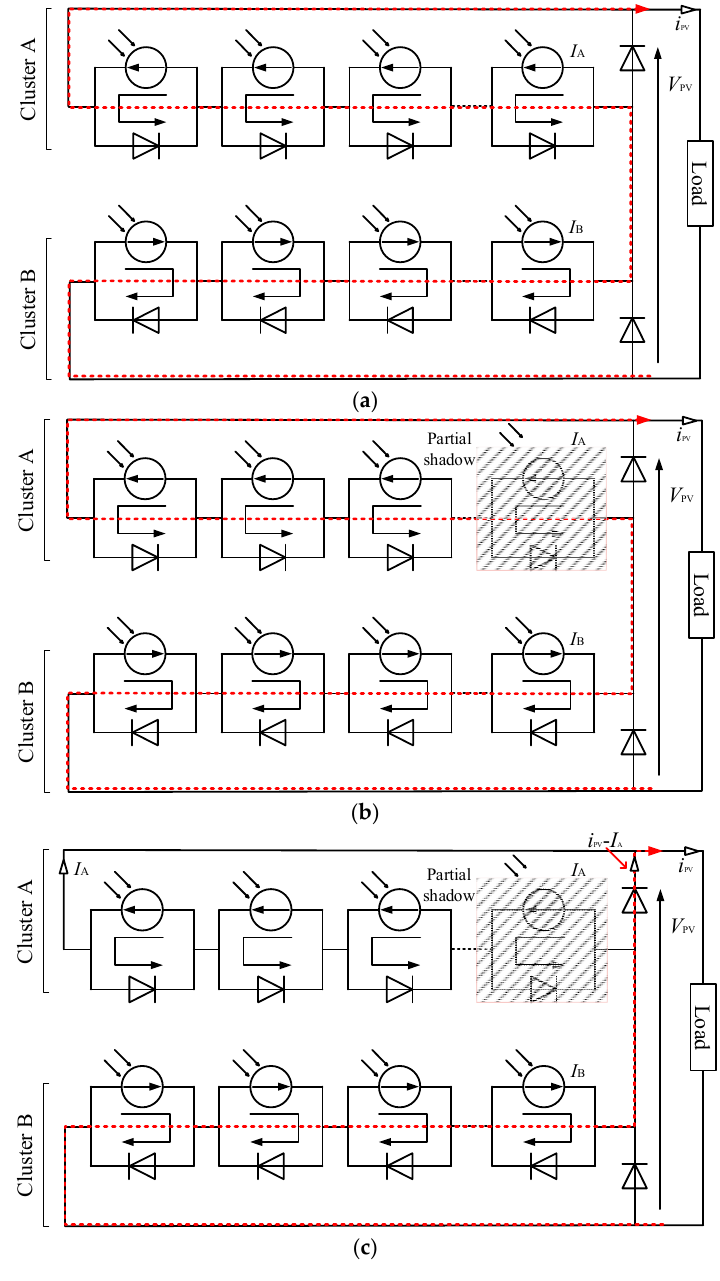
Figure 6. The equivalent circuit of a solar module, red dashed lines are operating current path: ( a ) Unshaded condition, I A = I B ; ( b ) Partial shadow on hot-spot cell I A < I B , I A ≥ i pv ; ( c ) Partial shadow on normal cell, I A < I B , I A < i pv .